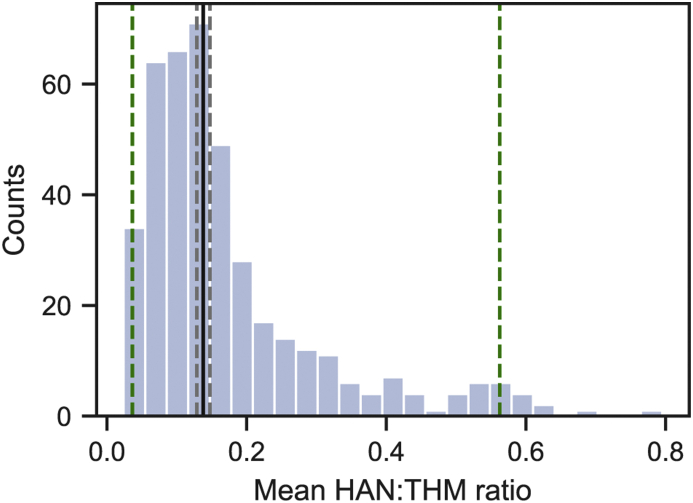
Histogram of geometric mean HAN:THM ratios estimated for 412 WTPs using the multilevel regression model described by Equation (2.1), (2.2). The black solid line indicates the mean, with grey dashed lines indicating the 95% confidence interval for the mean. The green dashed lines indicate the 2.5 and 97.5 percentiles. (For interpretation of the references to color in this figure legend, the reader is referred to the Web version of this article.)